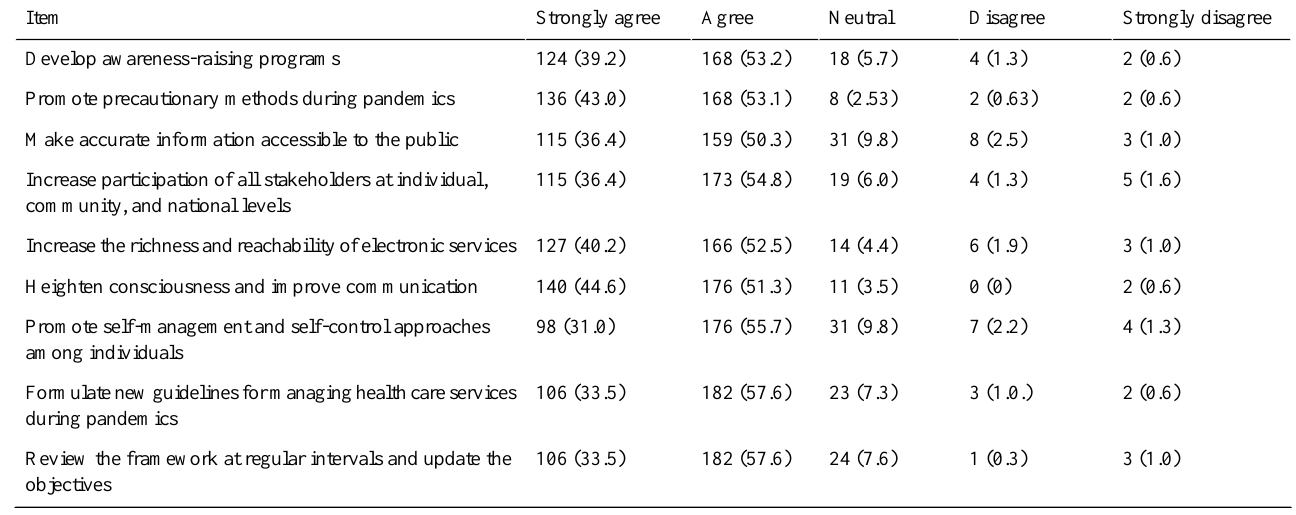
Table 3. Frequency distribution of key objectives to be included in the new eHealth framework (N=316), n (%).